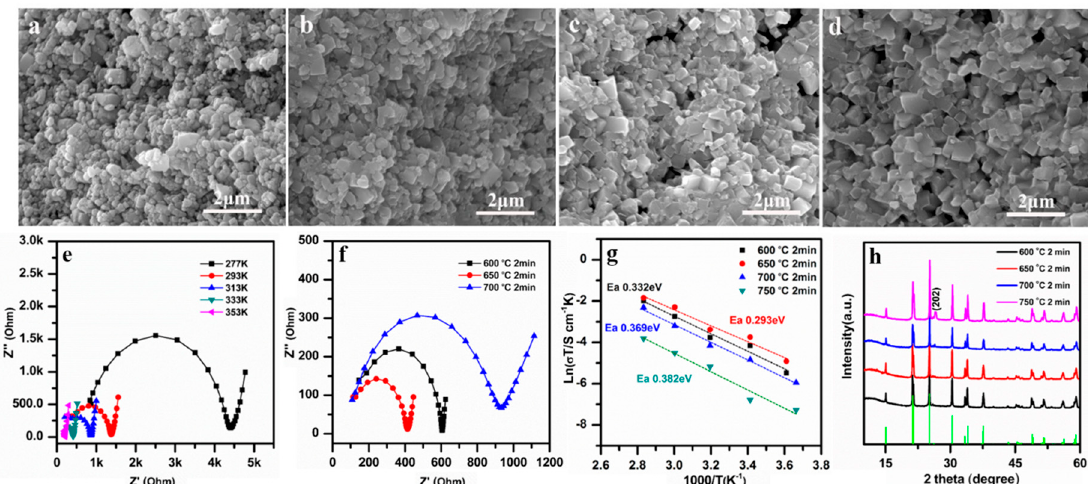
Figure 2. SEM images at cross sections of the LAGP pellets sintered by spark plasma sintering (SPS) for 2 min at ( a ) 600 ◦ C, ( b ) 650 ◦ C, ( c ) 700 ◦ C, and ( d ) 750 ◦ C; ( e ) Nyquist plots of the LAGP pellet, sintered at 650 ◦ C for 2 min; ( f ) Nyquist plots at room temperature (RT), ( g ) Arrhenius curves, and ( h ) XRD patterns of LAGP pellets, sintered by SPS for 2 min at 600 ◦ C, 650 ◦ C, 700 ◦ C, and 750 ◦